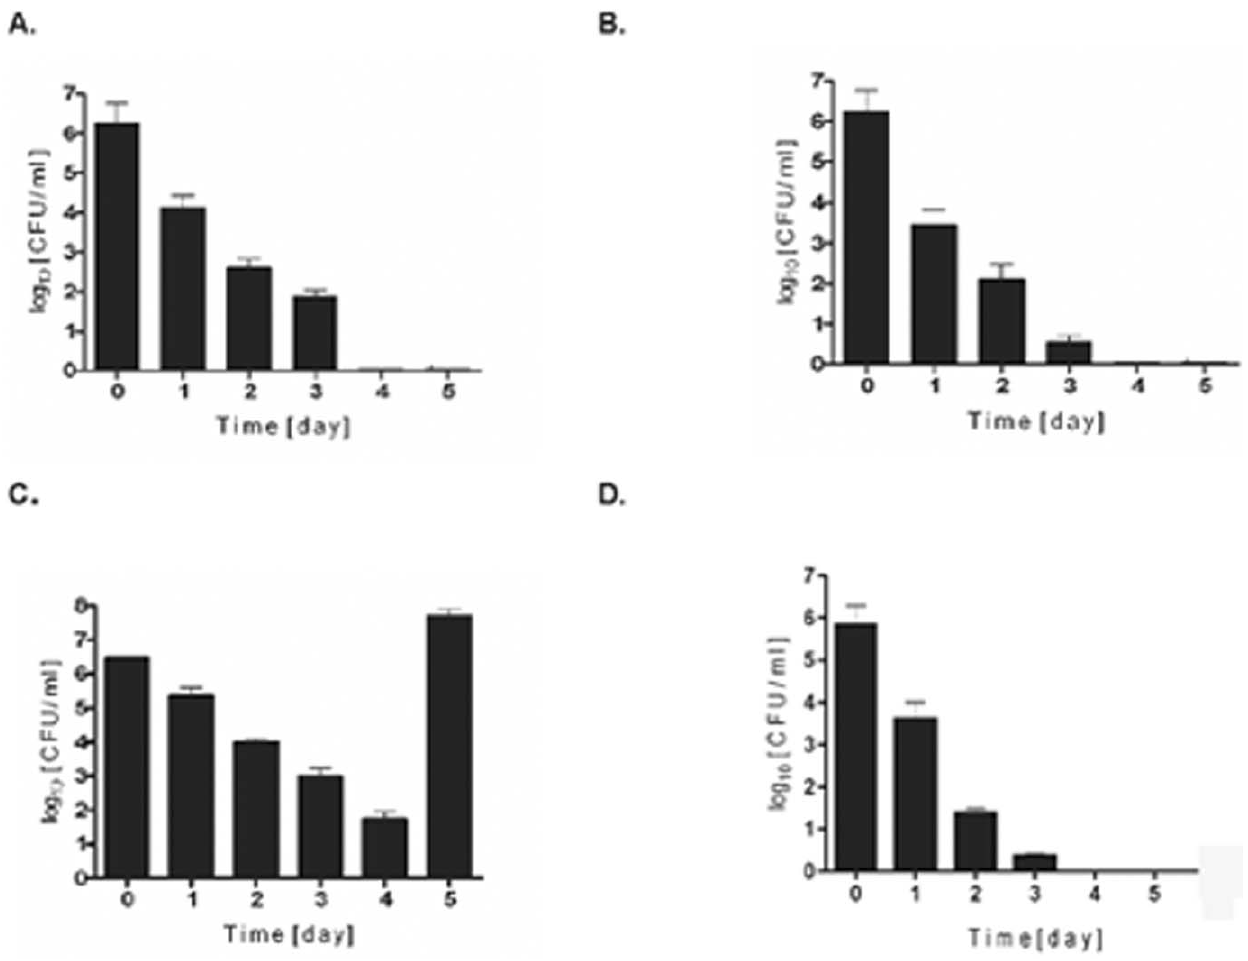
Figure 8. Metalloprotease (Aur), protein A, and MSCRAMs, but not the V8 protease (SspA) and staphopain B (SspB), contribute to S.aureus intracellular persistence in infected hMDMs. Intracellular persistence of S. aureus was determined as described in the legend of Fig. 3A. Bars represent mean CFU value 6 SD and are representative of at least three separate experiments, performed in triplicate, using hMDMs derived from different donors. A. Newman aur mutant B. Newman srtA mutant C. Newman ssp operon mutant D. Newman spA